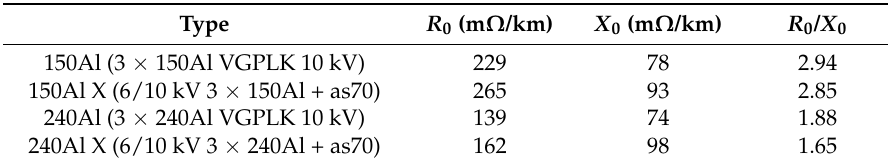
Table 2. Specifications of the cables used in the ArenA